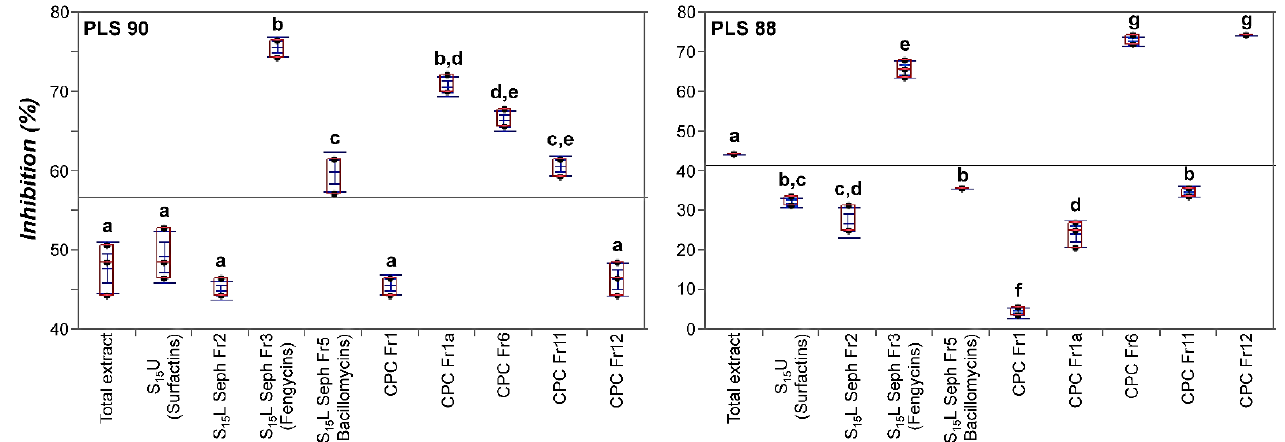
Figure 7. Effect of various fractions of the Bacillus sp. PTA13 lipopeptide extract on the radial growth of the Colletotrichum acutatum species complex isolates PLS 90 (wild type) and PLS 88 (resistant to PPPs) displayed using box plots. The fractions were applied at concentrations equal to the EC 50 of the total LP extract for PLS 90 (27 μ g mL − 1 ) and PLS 88 (63 μ g mL − 1 ). Three replications were performed per treatment and the different letters above boxes designate statically significant differences performing the Tukey HSD test ( p > 95%) (CPC; Centrifugal Partition Chromatography, L; Lower Phase, S; Biphasic Solvent System, Seph; Sephadex, U; Upper Phase).